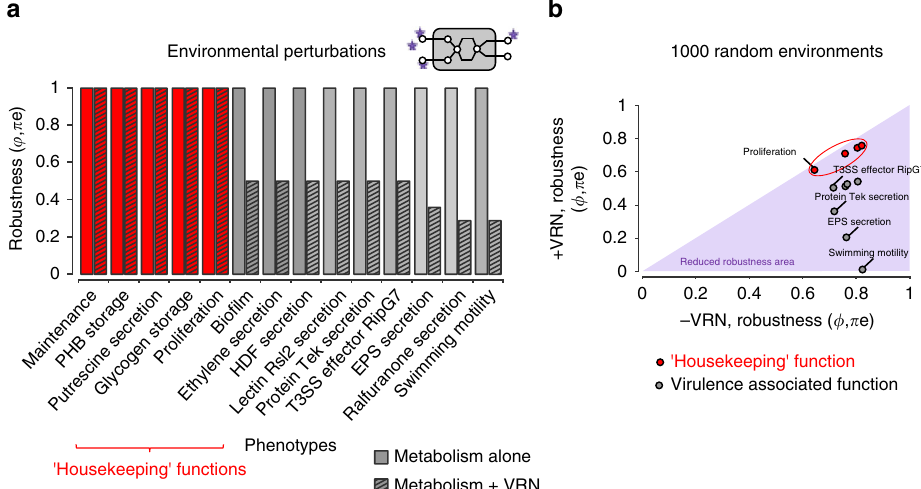
Fig. 4 The VRN restricts phenotypic robustness in presence of environmental perturbations. a Impact of the VRN on the phenotypic robustness in presence of environmental perturbations. The simulations were conducted in presence or absence of the VRN in 16 different environments, including in planta (e.g., plant tissues, high and low-cell density) and in vitro (e.g., complete medium, minimal medium) conditions. The detailed list of tested environments is provided in Supplementary Data 7. b Analysis of the impact of the VRN on phenotype robustness after simulation in presence of 1000 random